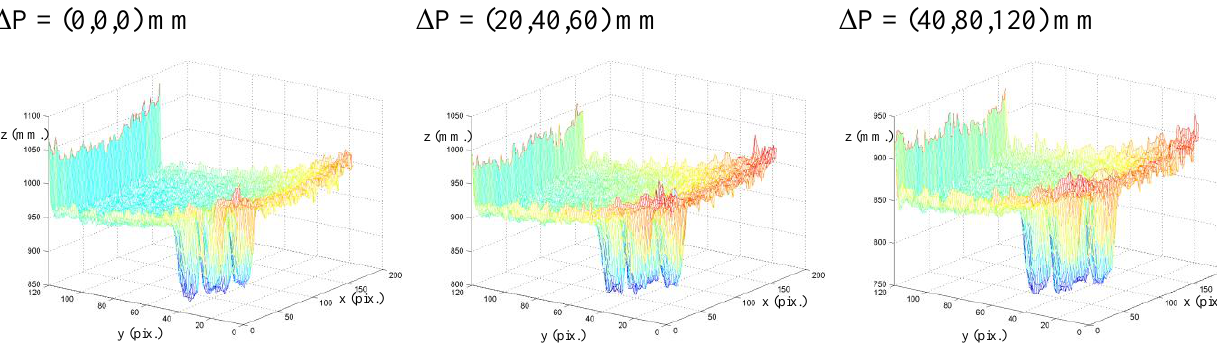
Figure 12. Range Image computed for the integration time updated at each